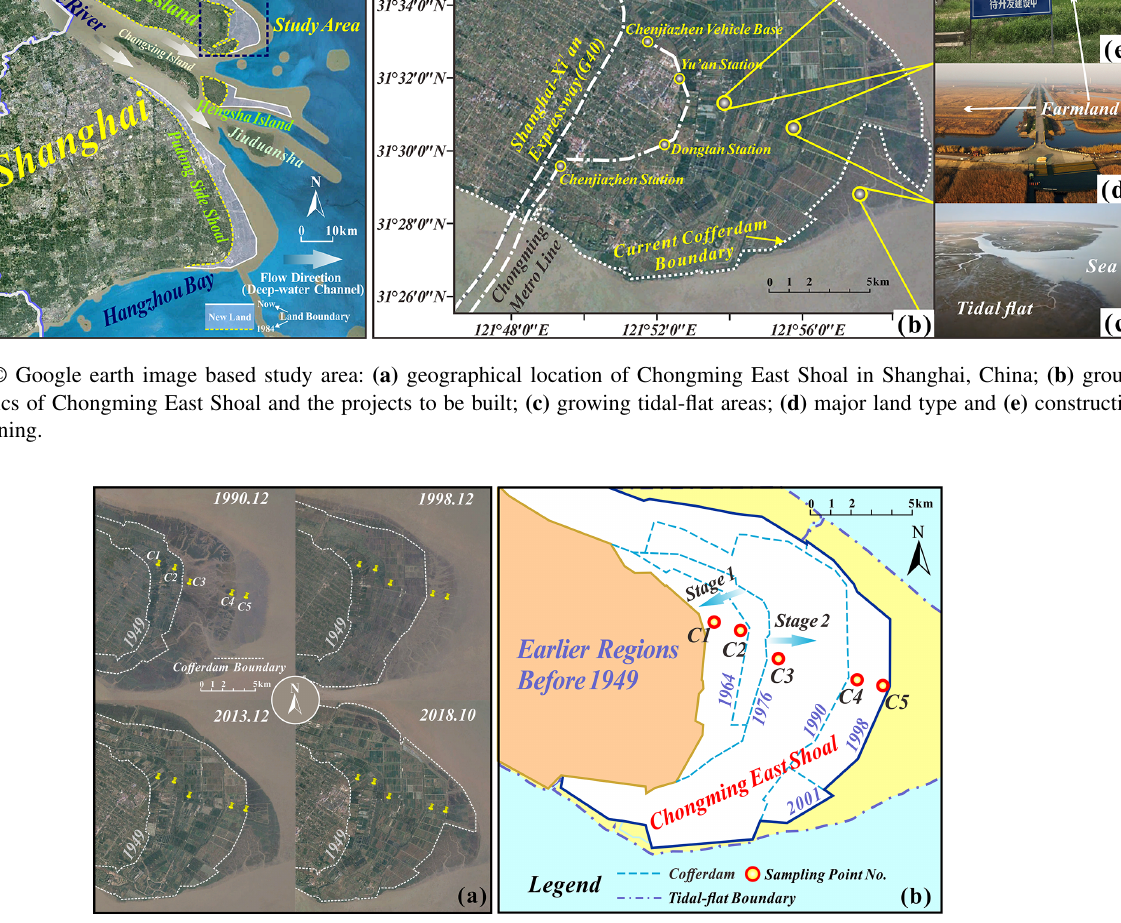
Figure 2. (a) Land evolution of CES since 1990s according to historical © Google earth images; (b) drilling survey points